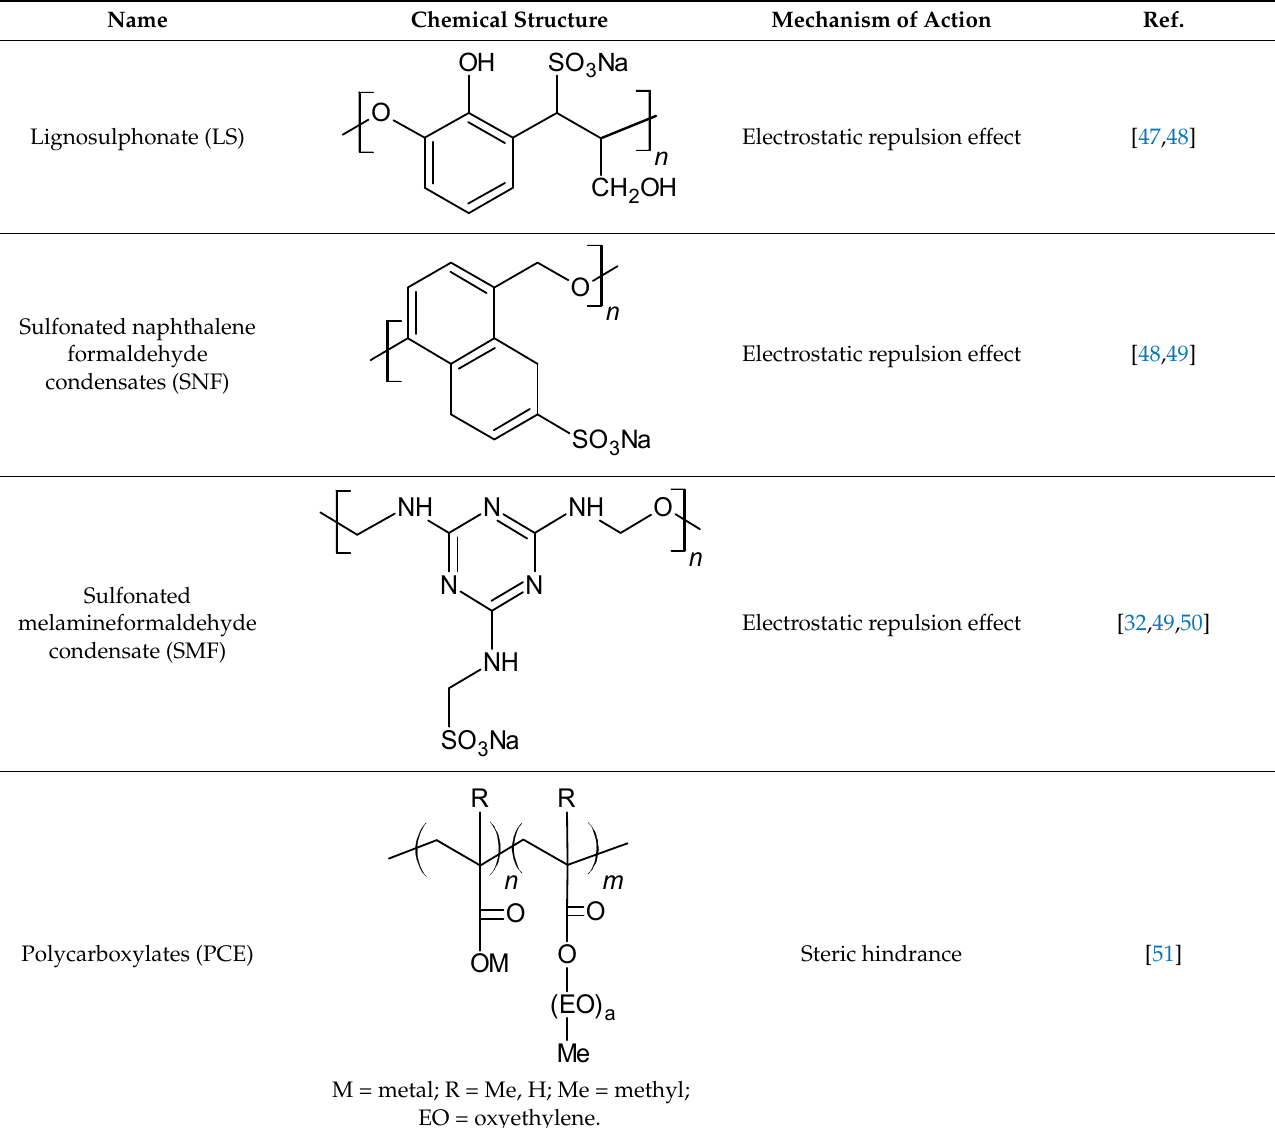
Table 1. The most popular superplasticizers.